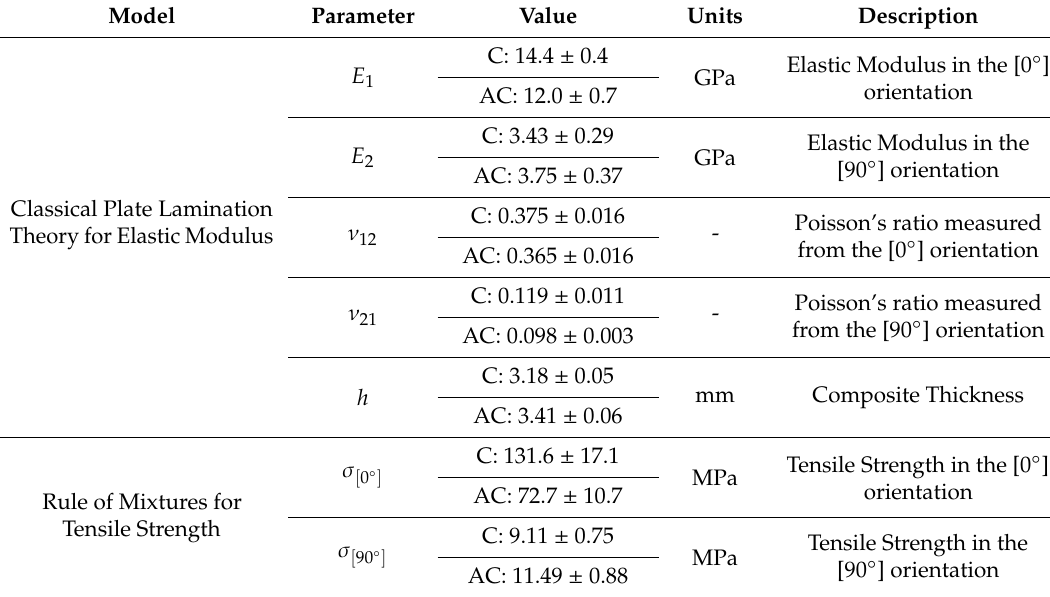
Table 4. Predicted elastic modulus and experimental mechanical response for 2-Ply TWC laminates.